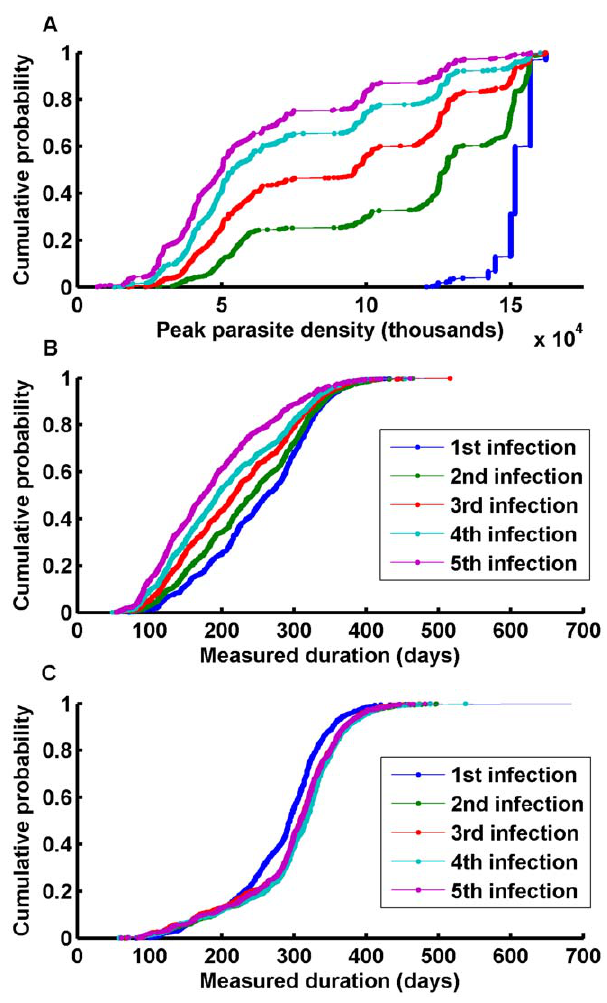
Figure 7. Measured durations and peak parasite counts for reinfection. Reinfection studies for the changes in A) peak parasite density; B) measured duration for random antigen selection; and C) measured duration for fixed minor epitope set and MSP variant but disjoint PfEMP-1 sets. The distributions of peak parasite count and measured duration are compared for the 1 st –5 th infection. Effect of reinfection on duration depends on the antigenic overlap between primary and secondary